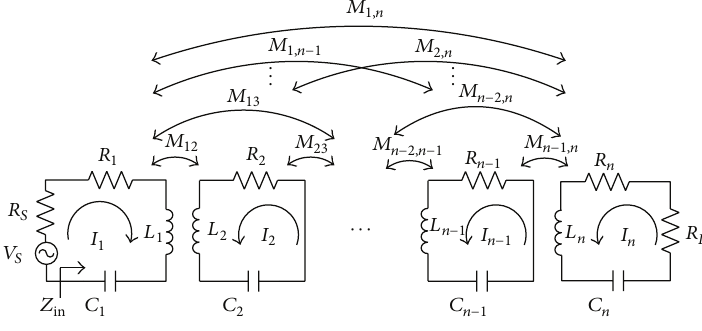
Figure 2: Equivalent circuit of asymmetrical relay